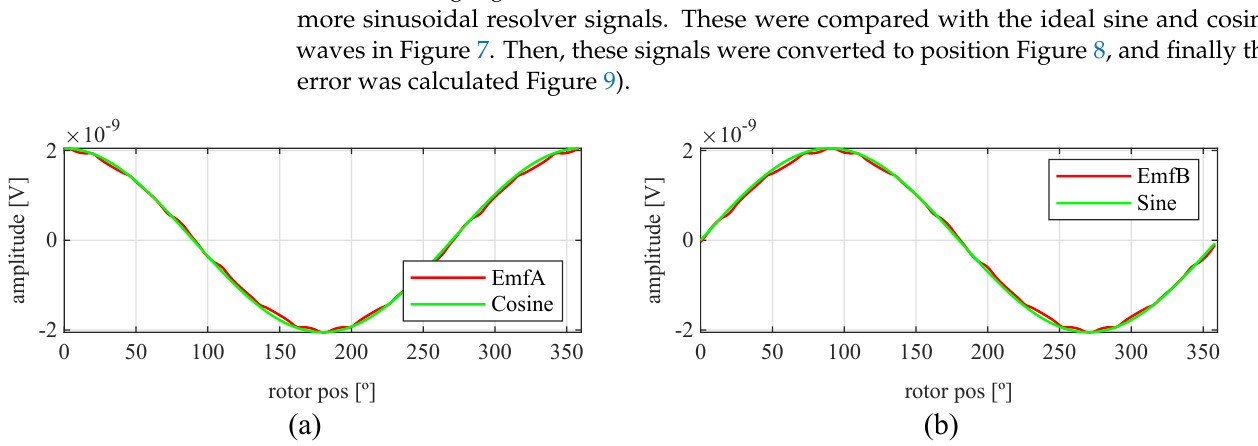
Figure 7. Full pitch four-slot skewed resolver EMFs vs. ideal signals ( a ) EMF A vs. Cosine and ( b ) EMF B vs.